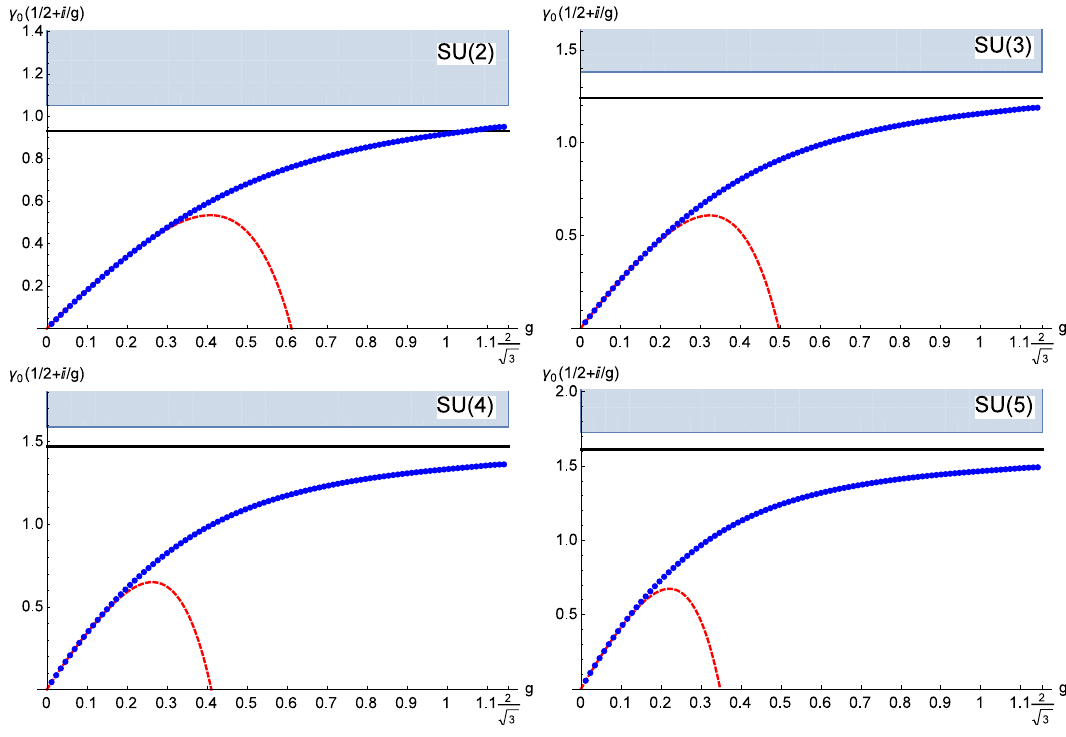
( (cid:28) = 1 = 2 + i=g ) 4